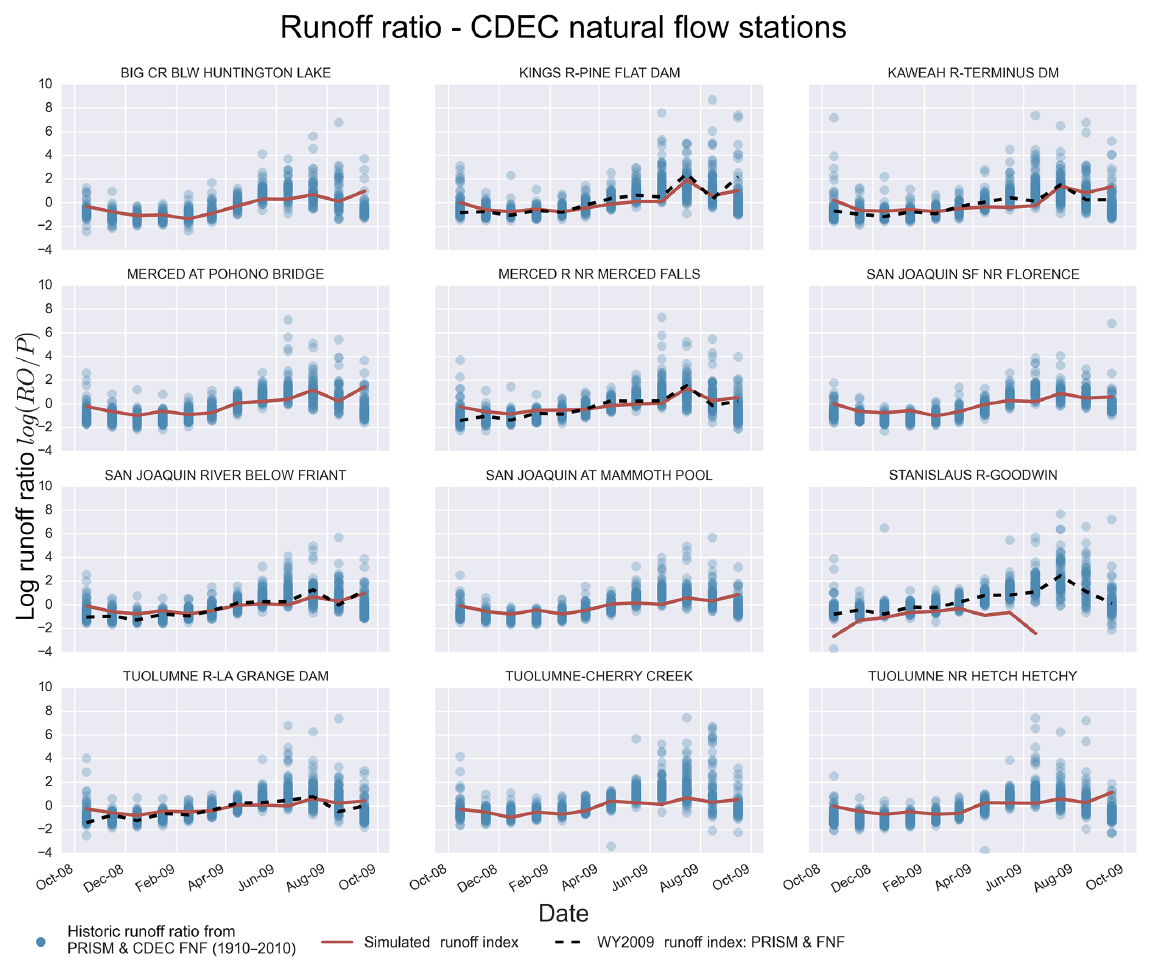
Figure 3. Monthly runoff ratio (streamflow volume as a fraction of monthly precipitation volume). Blue dots represent available historical record from 1910 to 2010 using PRISM precipitation product and the California Department of Water Resources estimated full natural flow (FNF) for 12 watersheds with gages in the San Joaquin River basin model domain. Simulated runoff ratio is shown as a red line. The dashed black line indicates the historical runoff ratio for water year 2009, where FNF station data